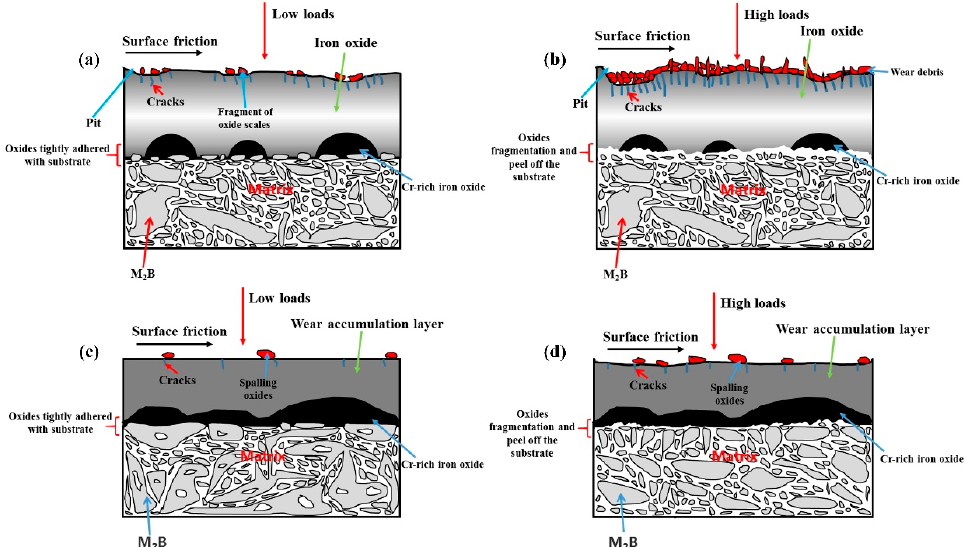
Figure 12. Schematic diagram of high-temperature wear processes and influence of temperatures and loads in HBHSSs: ( a ) low Cr sample under low temperatures and loads; ( b ) low Cr sample under high temperatures and loads; ( c ) high Cr sample under low temperatures and loads; ( d ) high Cr sample under high temperatures and loads.